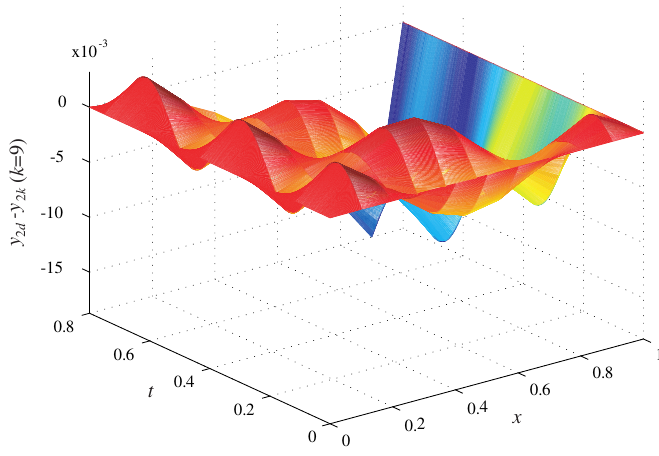
Figure 6. The error surface y 2 d − y 2 k ( k = 9 ) .